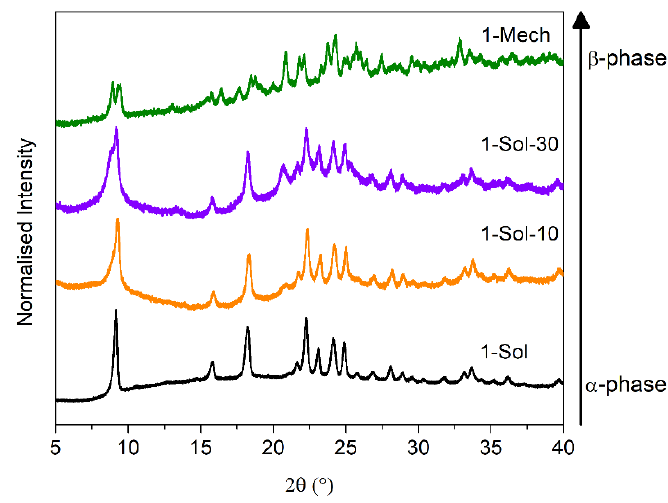
Figure 6. Normalised PXRD for 1-Mech , 1-Sol-30 , 1-Sol-10 and 1-Sol .